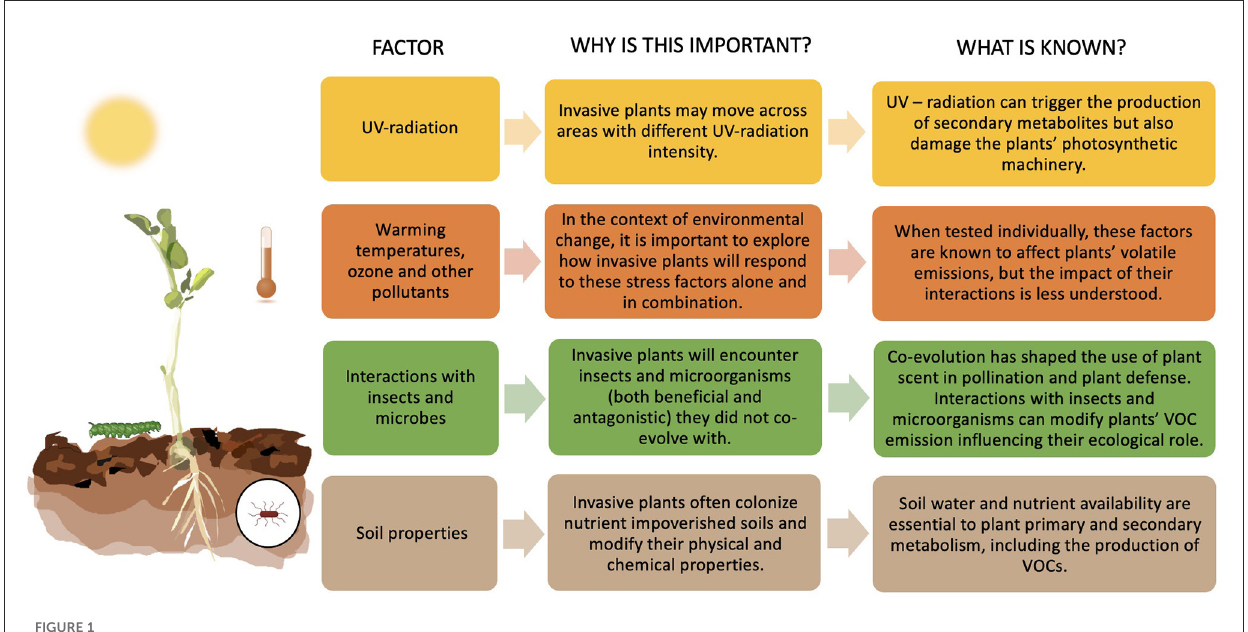
FIGURE1 Biotic and abiotic factors influencing VOC emissions of invasive plants.